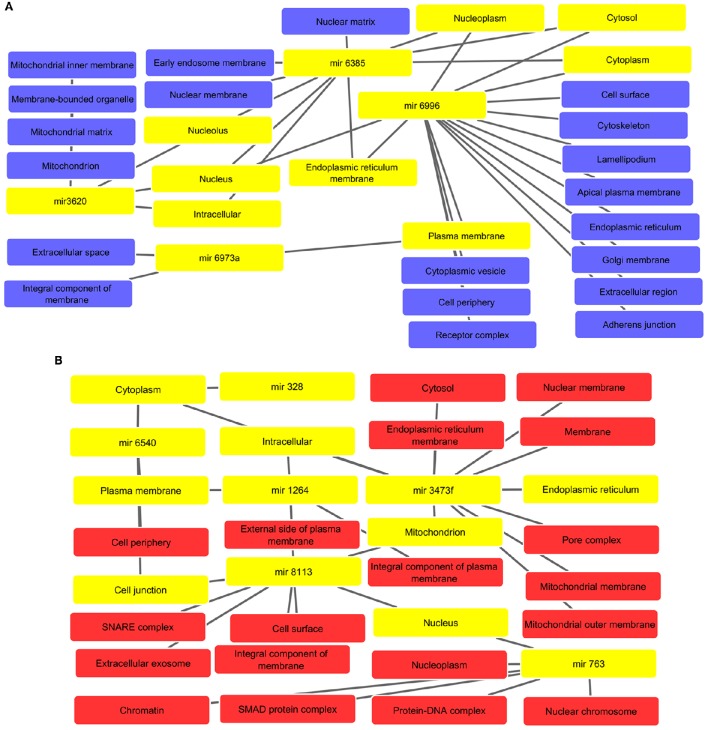
(A) Associated cellular components of up regulated miRNAs with interlinked miRNAs and their respective key cellular compartments highlighted with yellow color such as nucleoplasm, cytoplasm, and intracellular, etc. (B) Cellular components inferred from analysis of down regulated miRNA-targets. The highlighted yellow color denotes interlinked miRNAs and their respective key cellular components like cytoplasm, plasma membrane, mitochondrion, and cell junction, etc.